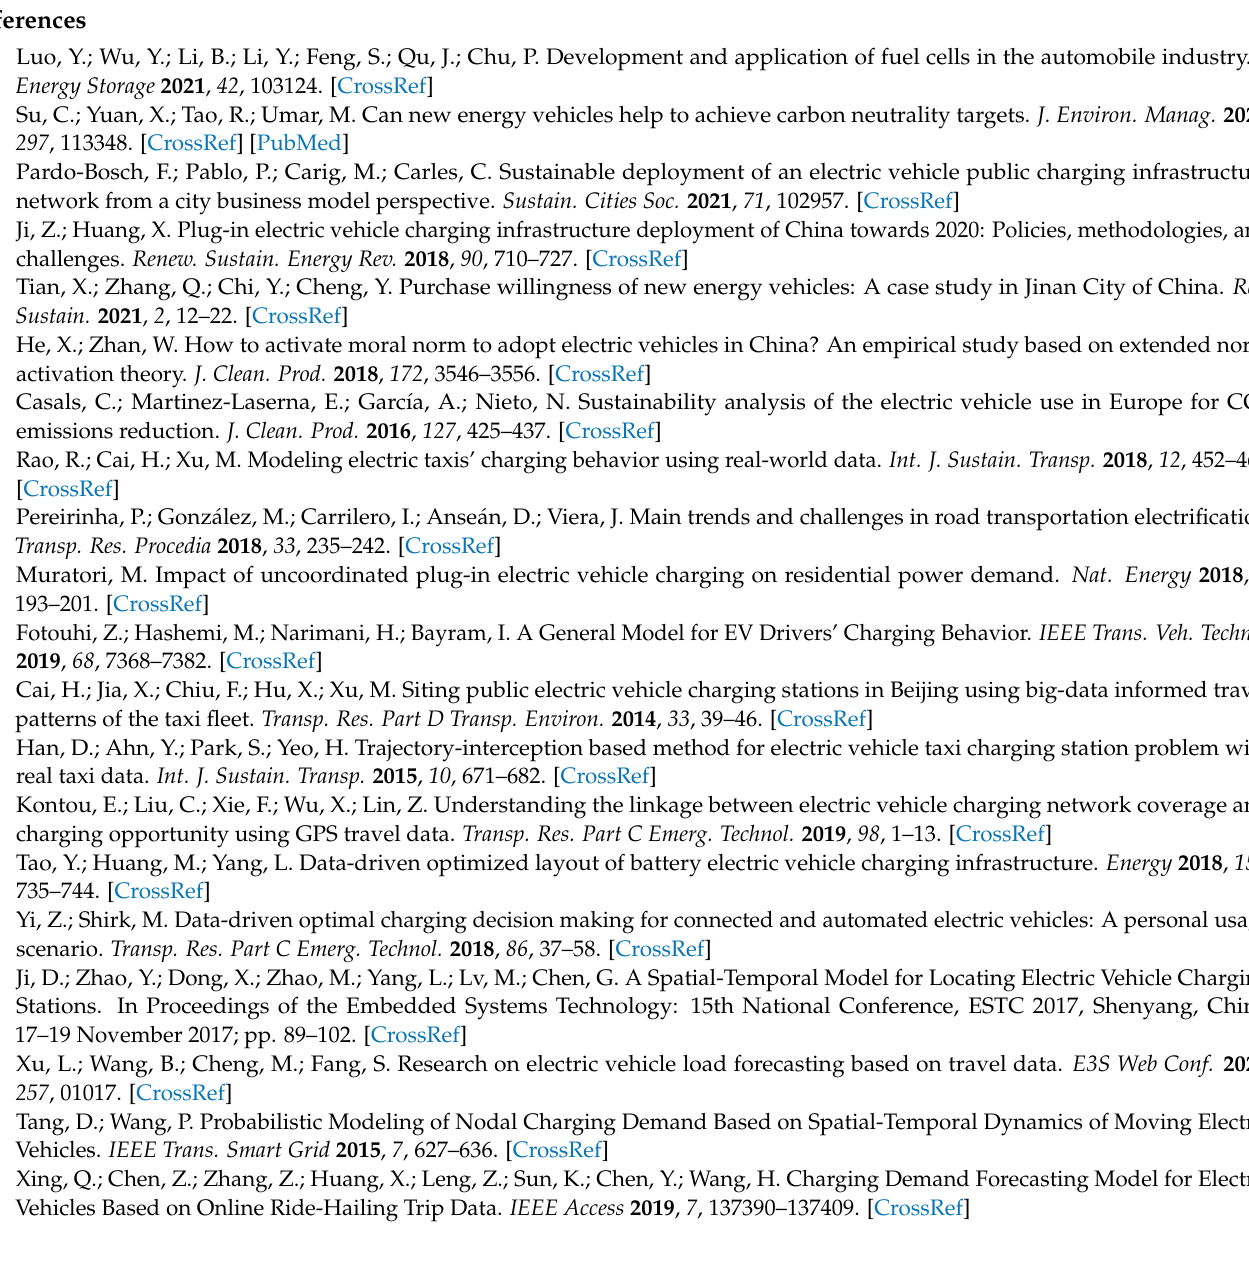
Figure A15. The convergence curve for solving